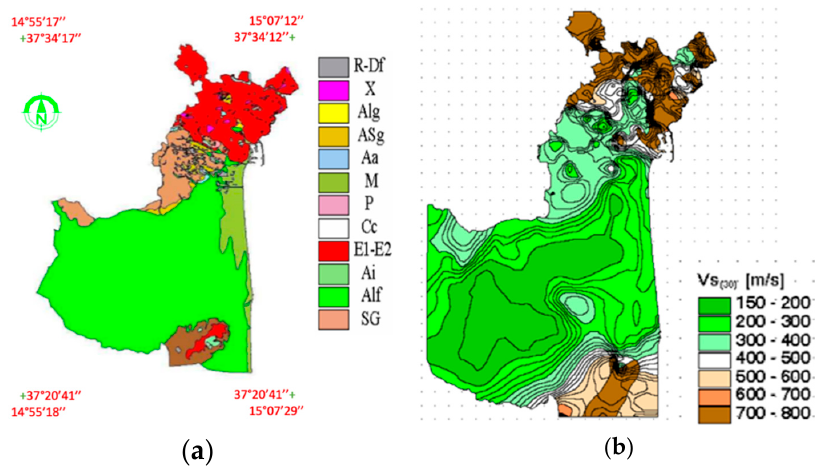
Figure 2. Flow chart of the adopted procedure.